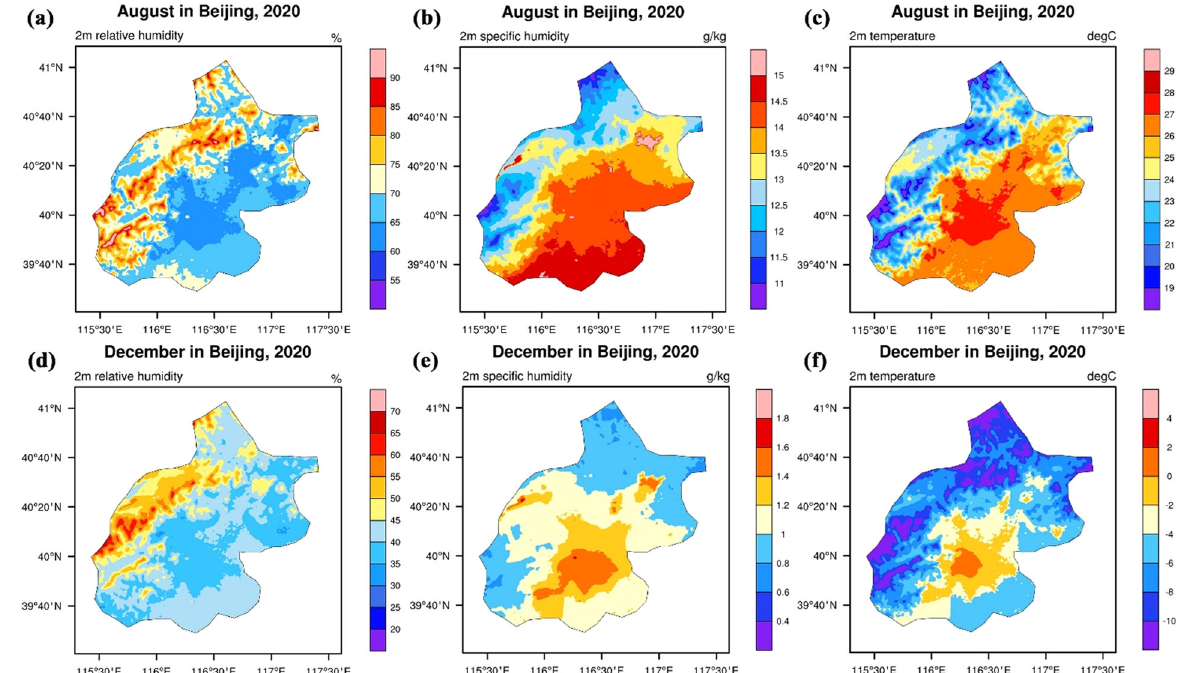
Fig. 5 Beijing experiences a dry island effect during summer and a wet island effect during winter. Average ( a – c ) summer (August average values) and ( d - f ) winter (December average values) simulation results for 2 m relative humidity (%) ( a and d ), 2 m air speci fi c humidity (g/kg) ( b and e ) and 2 m air temperature (°C) ( a and f